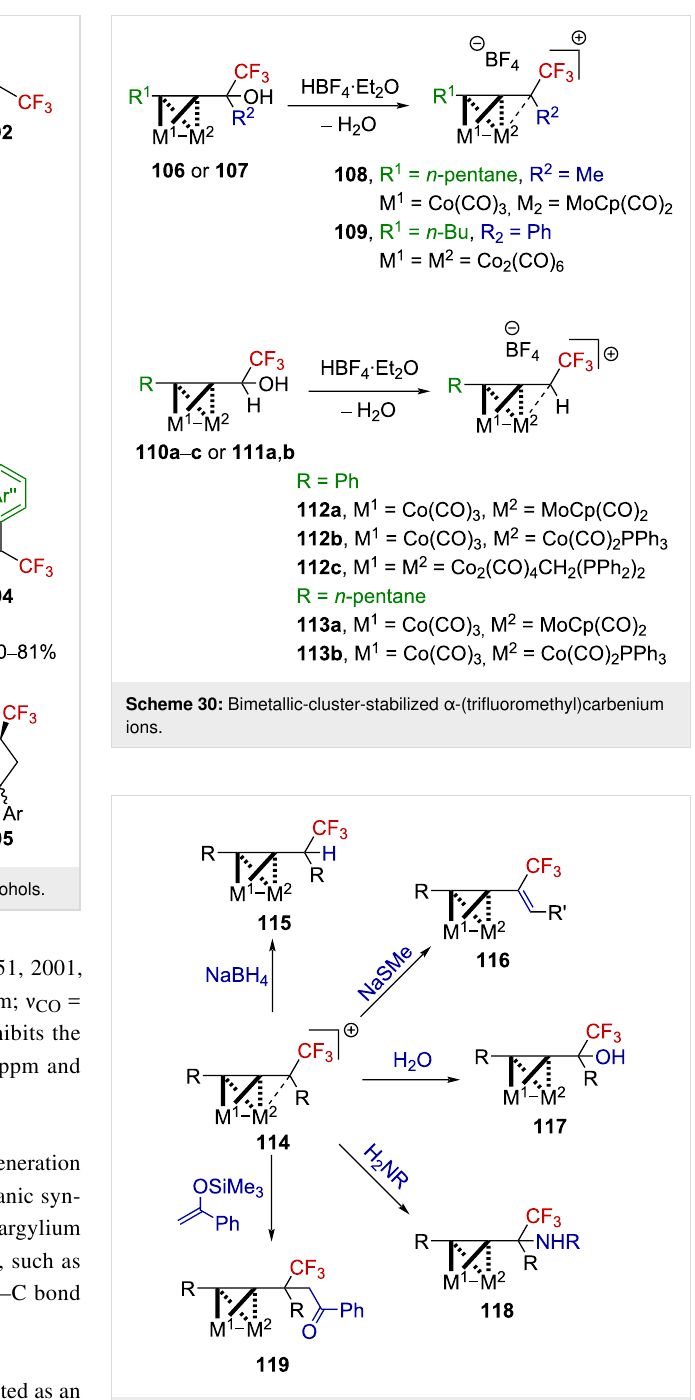
122’ reacts in a Friedel–Crafts reaction with benzene to generate 123 . After two successive hydroarylation reactions, the final product 121 is produced via the formation of vinylic and benzylic carbenium ions 124 and 125 , respectively (Scheme